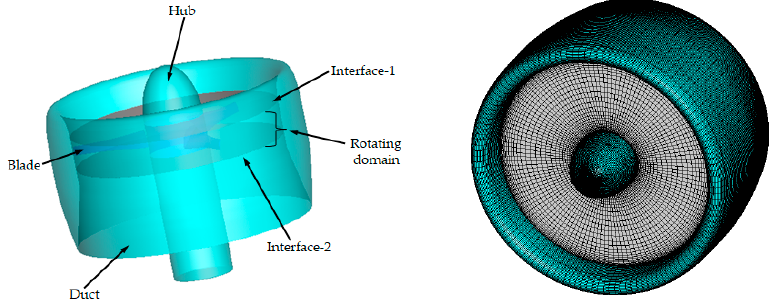
Figure 1. Three-blade ducted propeller and its surface mesh. Figure 1. Three ‐ blade ducted propeller and its surface mesh.